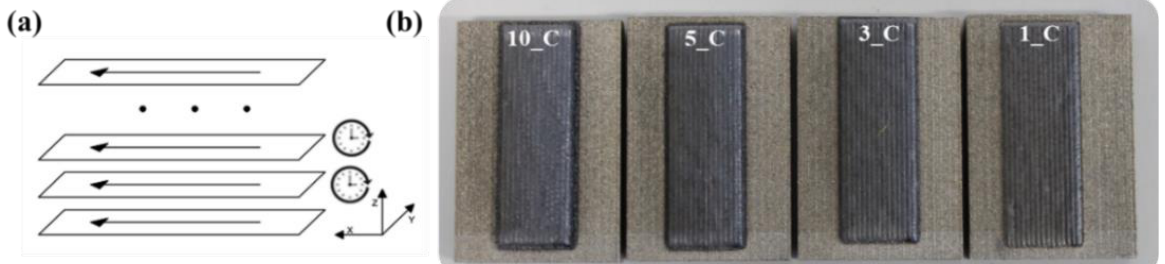
Figure 4. ( a ) Schematic representation of the deposition strategy and ( b ) DED coatings on L-PBF substrates. The process parameters for the deposition of coatings were: laser power = 400 W, spot diameter = 1.5 mm, scanning speed = 1000 mm/min, powder feed rate = 5.0 g/min, carrier Table 2. Taguchi orthogonal L36 preliminary single-track experimental plan. Process Parameter